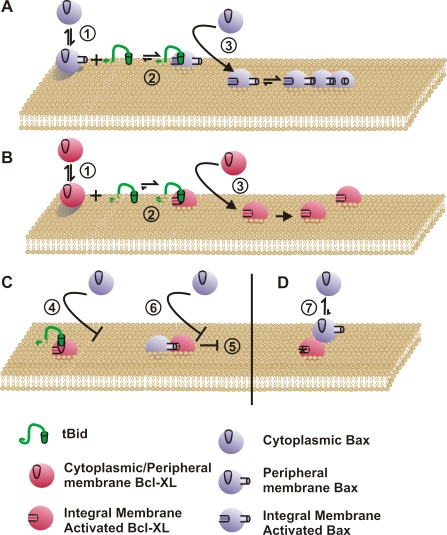
Bcl-XL Functions Like a Dominant-Negative Bax(A) Cytoplasmic Bax undergoes a conformational change after interacting with membranes (step 1). Interaction of this peripheral membrane (indicated by the shadow) Bax with membrane-bound tBid causes a further conformational change such that Bax integrates in the membrane in an oligomerization competent form (step 2). Conversely, cytoplasmic Bax may interact with other activator proteins to integrate into membranes, or spontaneously active Bax molecules may integrate into the membrane without binding an activator protein. A single tBid molecule activates multiple peripheral membrane Bax molecules, and/or the activated integral membrane Bax recruits more cytoplasmic Bax to the membrane (autoactivation, step 3). Bax oligomerizes.(B) Bcl-XL exists in a cytoplasmic and/or a peripheral membrane-bound form (step 1). Membrane-bound tBid triggers membrane binding and activation of Bcl-XL (step 2). One tBid molecule can mediate the membrane binding and activation of multiple Bcl-XL molecules (step 3). Bcl-XL does not oligomerize.(C) Membrane-bound Bcl-XL sequesters tBid and thereby prevents the activation of Bax (step 4). Bcl-XL binds to membrane-bound Bax, preventing Bax oligomerization (step 5) and the recruitment of further peripheral Bax by autoactivation (step 6). In steps 4–6, Bcl-XL functions as a dominant-negative Bax.(D) Bcl-XL inhibits the conformational change of Bax (step 7, indicated as a change in equilibrium) that is elicited by peripheral membrane binding (step 1 in (A)).